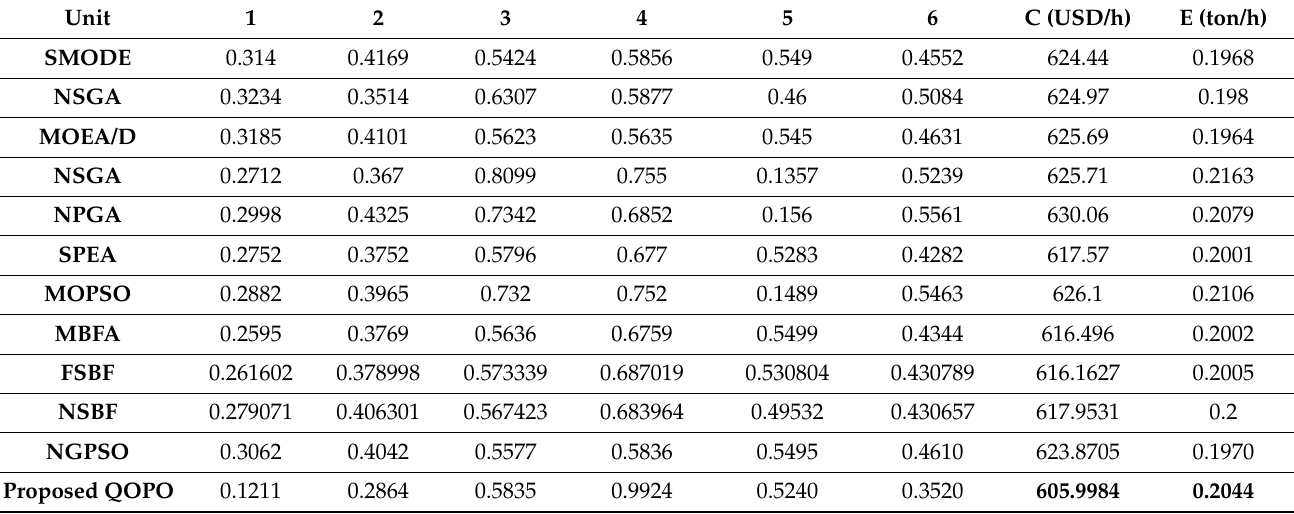
Table 9. Comparison of results of six-unit system for the load demand of 2.834 p.u.